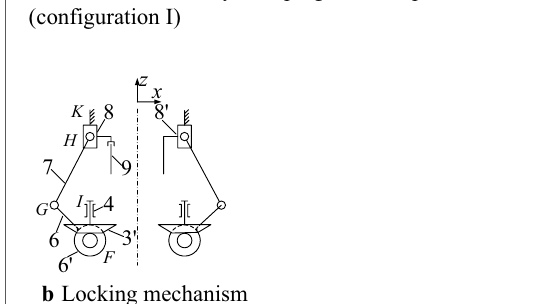
Figure 17 Proposed broken strands reposition metamorphic mechanism